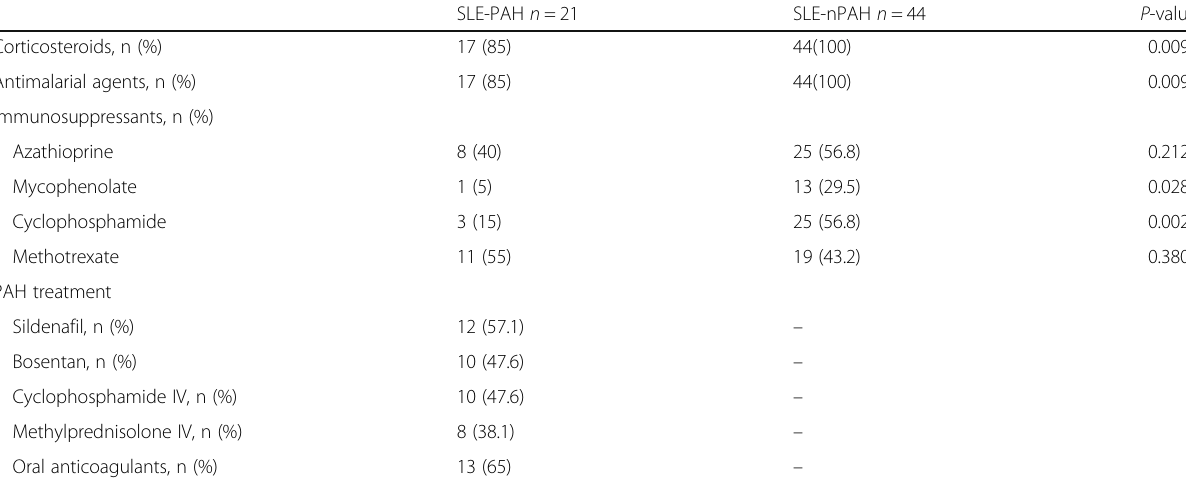
SLE-PAH n = 21 SLE-nPAH n = 44